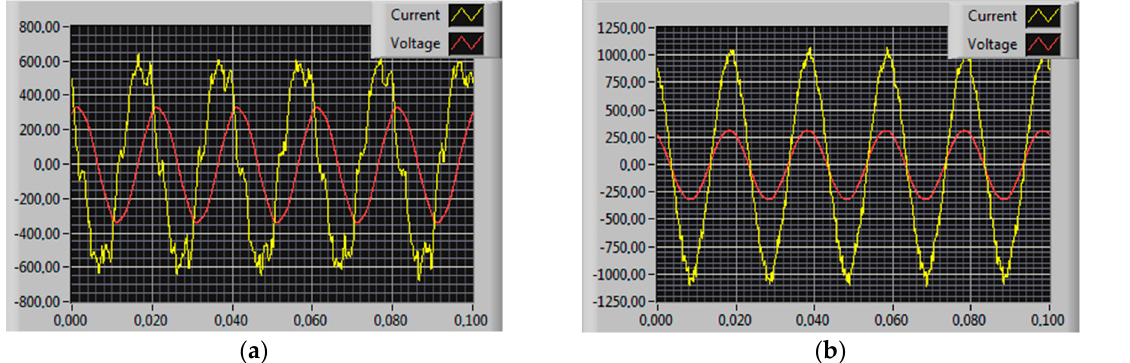
Figure 13. A-phase voltage and current waveforms registered in the secondary of the transformer in periods of ( a ) small power consumptions and ( b ) high power consumptions.